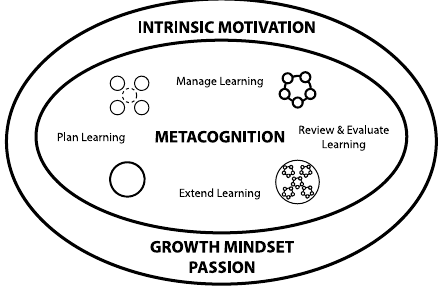
Figure 6: Application of peer to peer learning within the framework of self directed learning. Source: